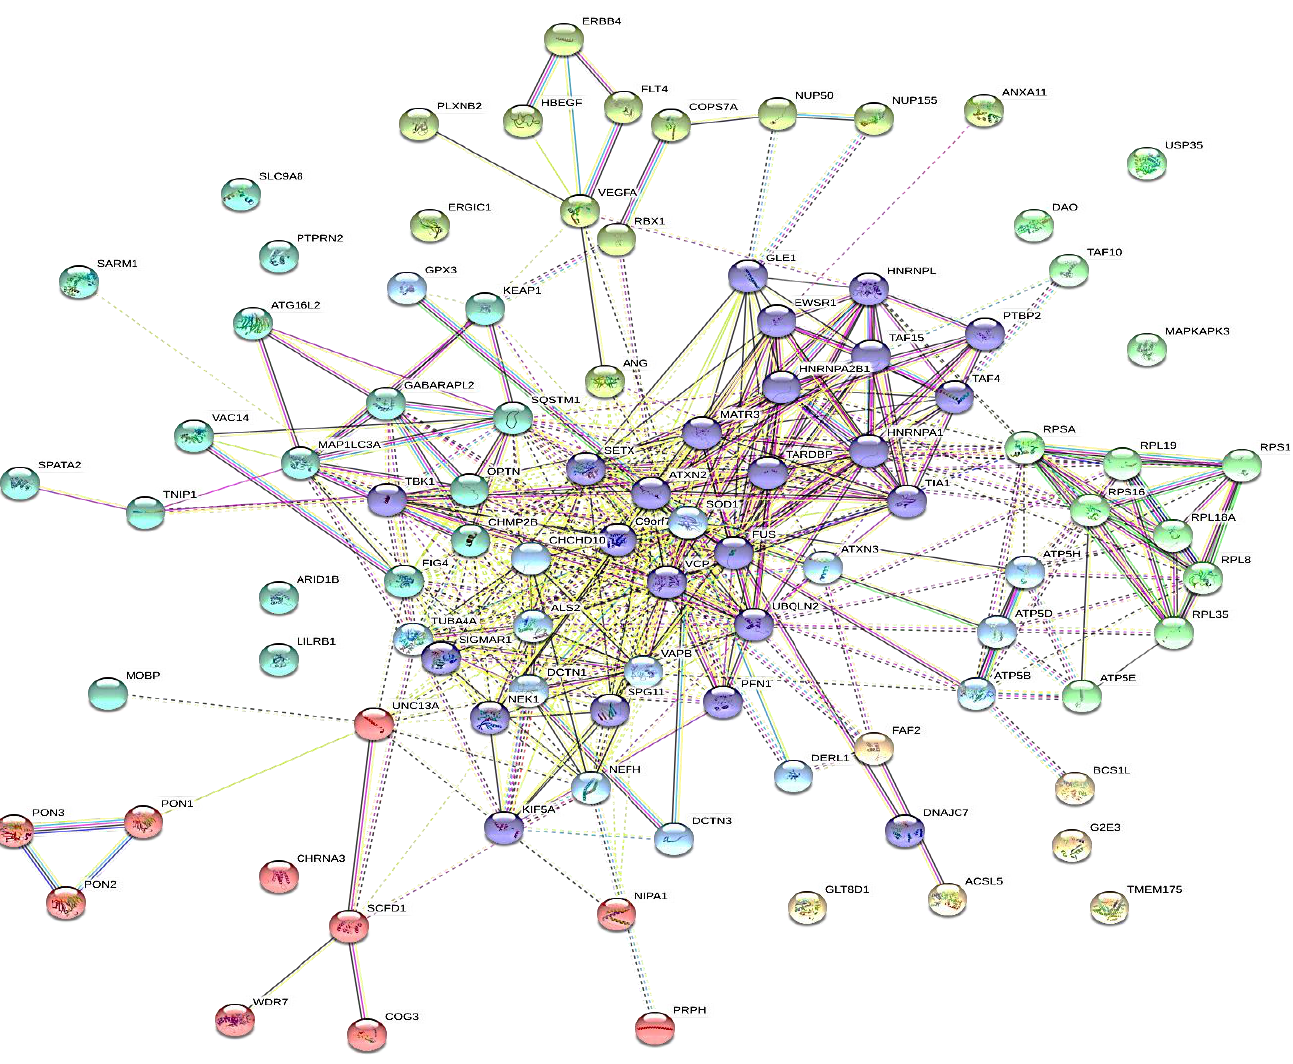
Figure 2. Protein-protein interactions of all the ALS-associated genes, visualized with k-mean clustering into seven clusters. Legend: Cluster 1: red (CHRNA3, COG3, NIPA1, PON1, PON2, PON3, PRPH, SCFD1, UNC13A, and WDR7). Cluster 2: brown (ACSL5, BCS1L, FAF2, G2E3, GLT8D1, and TMEM175). Cluster 3: olive (ANG, ANXA11, COPS7A, ERBB4, ERGIC1, FLT4, HBEGF, NUP155, NUP50, PLXNB2, RBX1, and VEGFA). Cluster 4: green (ATP5E, DAO, MAPKAPK3, RPL18A, RPL19, RPL35, RPL8, RPS12, RPS16, RPSA, TAF10, and USP35). Cluster 5: blue (ARID1B, ATG16L2, CHMP2B, FIG4, GABARAPL2, KEAP1, LILRB1, MAP1LC3A, MOBP, OPTN, PTPRN2, SARM1, SLC9A8, SPATA2, SQSTM1, TNIP1, and VAC14). Cluster 6: light sky blue (ALS2, ATP5B, ATP5D, ATP5H, ATXN3, CHCHD10, DCTN1, DCTN3, DERL1, GPX3, NEFH, SOD1, TUBA4A, and VAPB). Cluster 7: medium blue (ATXN2, C9orf72, DNAJC7, EWSR1, FUS, GLE1, HNRNPA1, HNRNPA2B1, HNRNPL, KIF5A, MATR3, NEK1, PFN1, PTBP2, SETX, SIGMAR1, SPG11, TAF15, TAF4, TARDBP, TBK1, TIA1, UBQLN2, and VCP). Dotted lines show inter-cluster interactions.